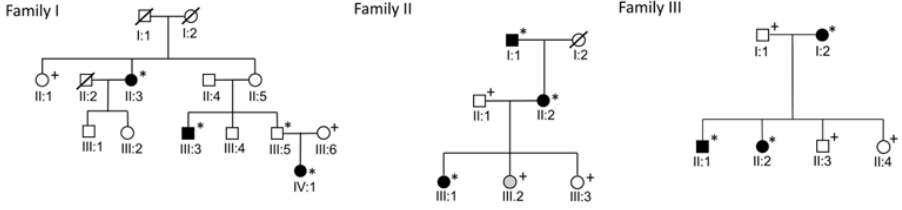
Figure 1. Pedigrees of the families. Individuals with definite MD are marked with black symbols and individual with possible MD marked with gray symbols. Individuals marked with asterisks were included in the exome sequencing and individuals with plus symbols were genotyped.